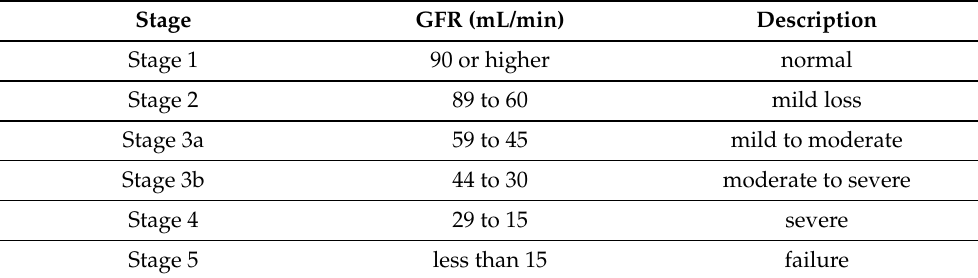
Table 2. Stage of glomerular filtration rate (GFR)